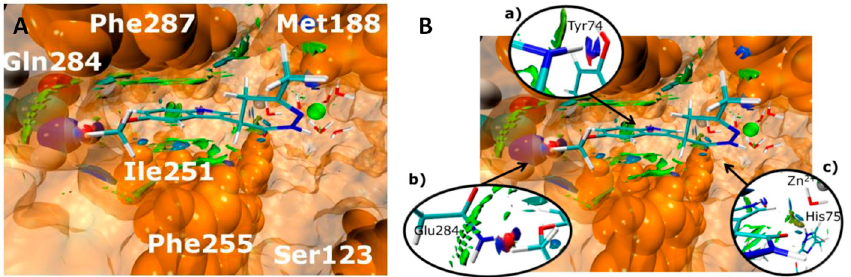
Figure 1. PDE4-3c interface, using promolecular densities. ( A ) best pose ( ⊗ G = − 5.3 kcal·mol − 1 ) and ( B ) focus on specific interactions.